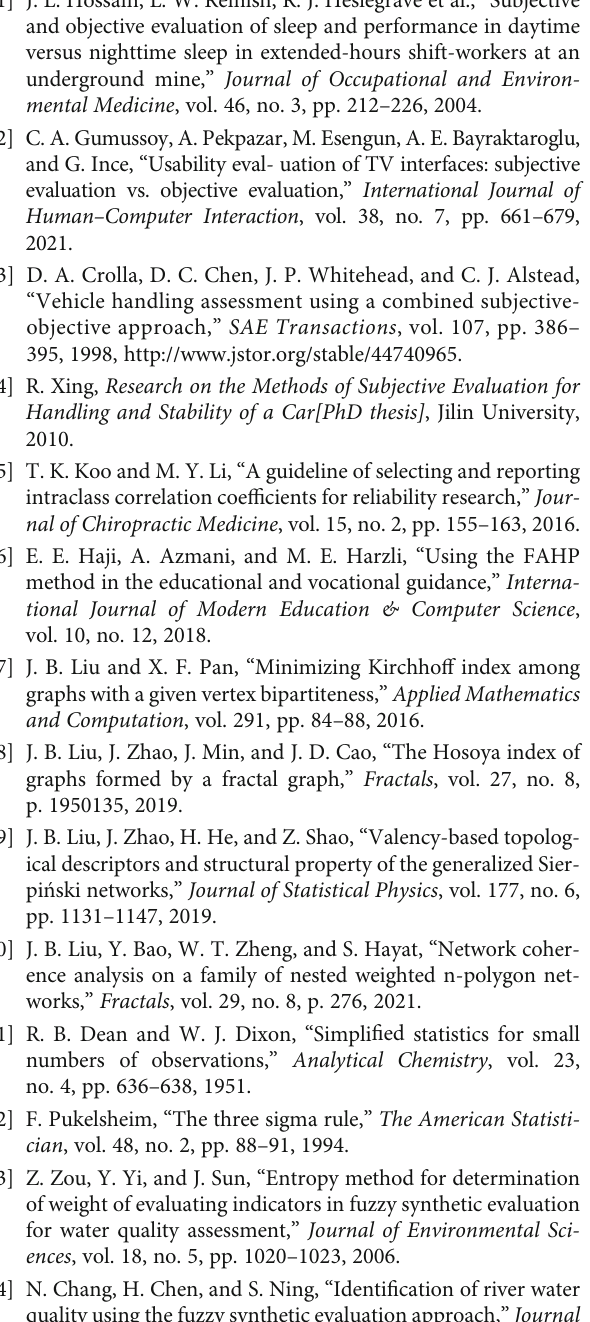
Table 1: the fi nal scores and rankings of all the students in both classes in the fi rst situation. Table 2: the fi nal scores and rankings of the students in class 1. Rankings are cal- culated among all the students in both classes. Table 3: the fi nal scores and rankings of the students in class